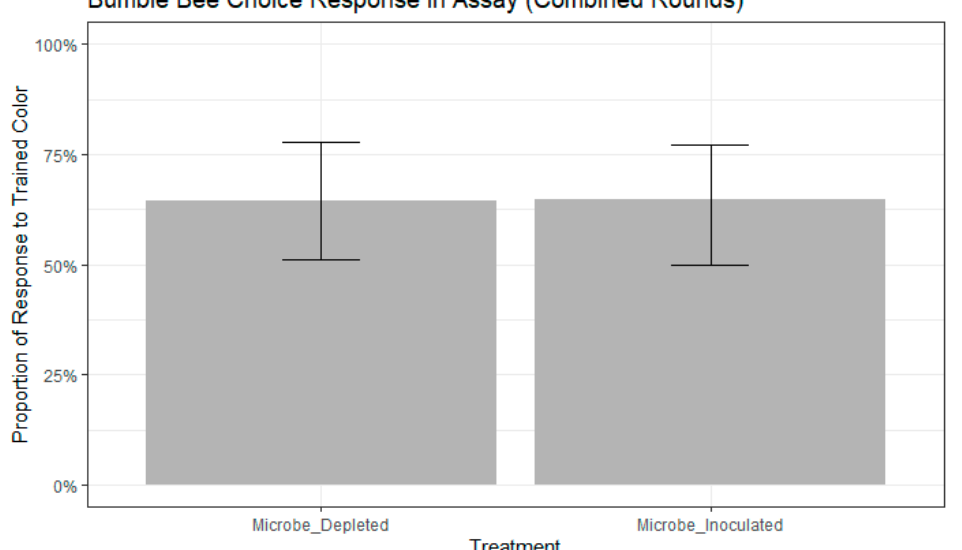
Figure 3. Bumble bee choice response to the trained color, the novel color, or neither color during the FMPER assay. No significance between treatments as determined by binomial GLMM with maximum likelihood: std. error = 0.4501, z = − 0.015, p = 0.988). Error bars indicate 95% confidence intervals. There was, however, an effect of treatment on mortality during round 2 (Kaplan–Meier log-rank test, chi-squared = 42.3, df = 9, p < 0.0001) of the experiment, but not during round 1 (Kaplan–Meier log-rank test, chi-squared = 4.3, df = 7, p = 0.7) (Figure 4A,B). In round 2, the significance in mortality